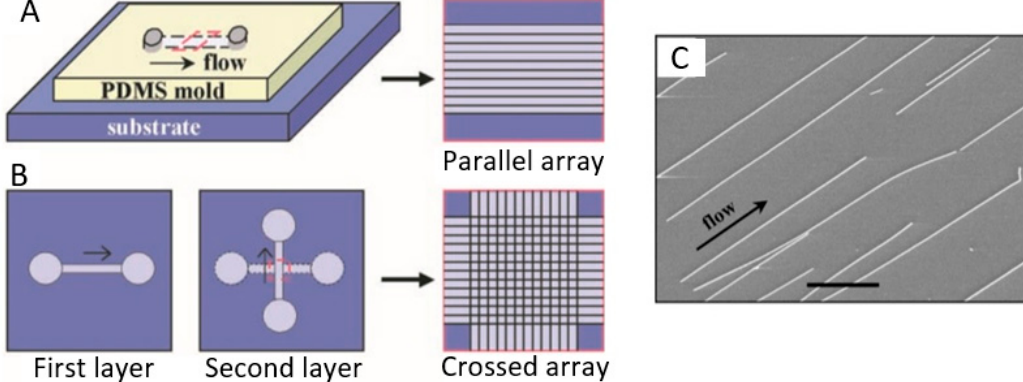
Figure 15. Schematic of fluidic channel structures for flow assembly: ( A ) A channel formed when the polydimethylsiloxane (PDMS) mold was brought in contact with a flat substrate. The NW assembly was carried out by flowing a NW suspension inside the channel with the controlled flow rate for a set duration. Parallel arrays of NWs are observed in the flow direction on the substrate when the PDMS mold is removed. ( B ) The multiple crossed NW array can be obtained by changing the flow direction sequentially in a layer-by-layer assembly process. ( C ) SEM image of the parallel assembly of NW arrays formed using the micro fluidics method. Reproduced with permission from Huang et al. [270].